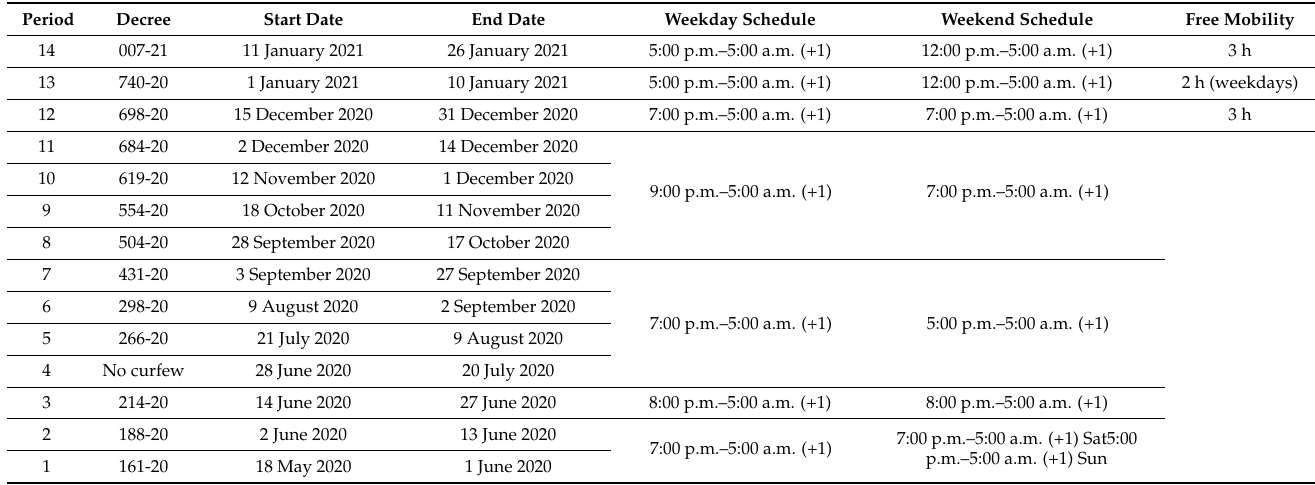
Table 2. Curfew schedule established by the Dominican